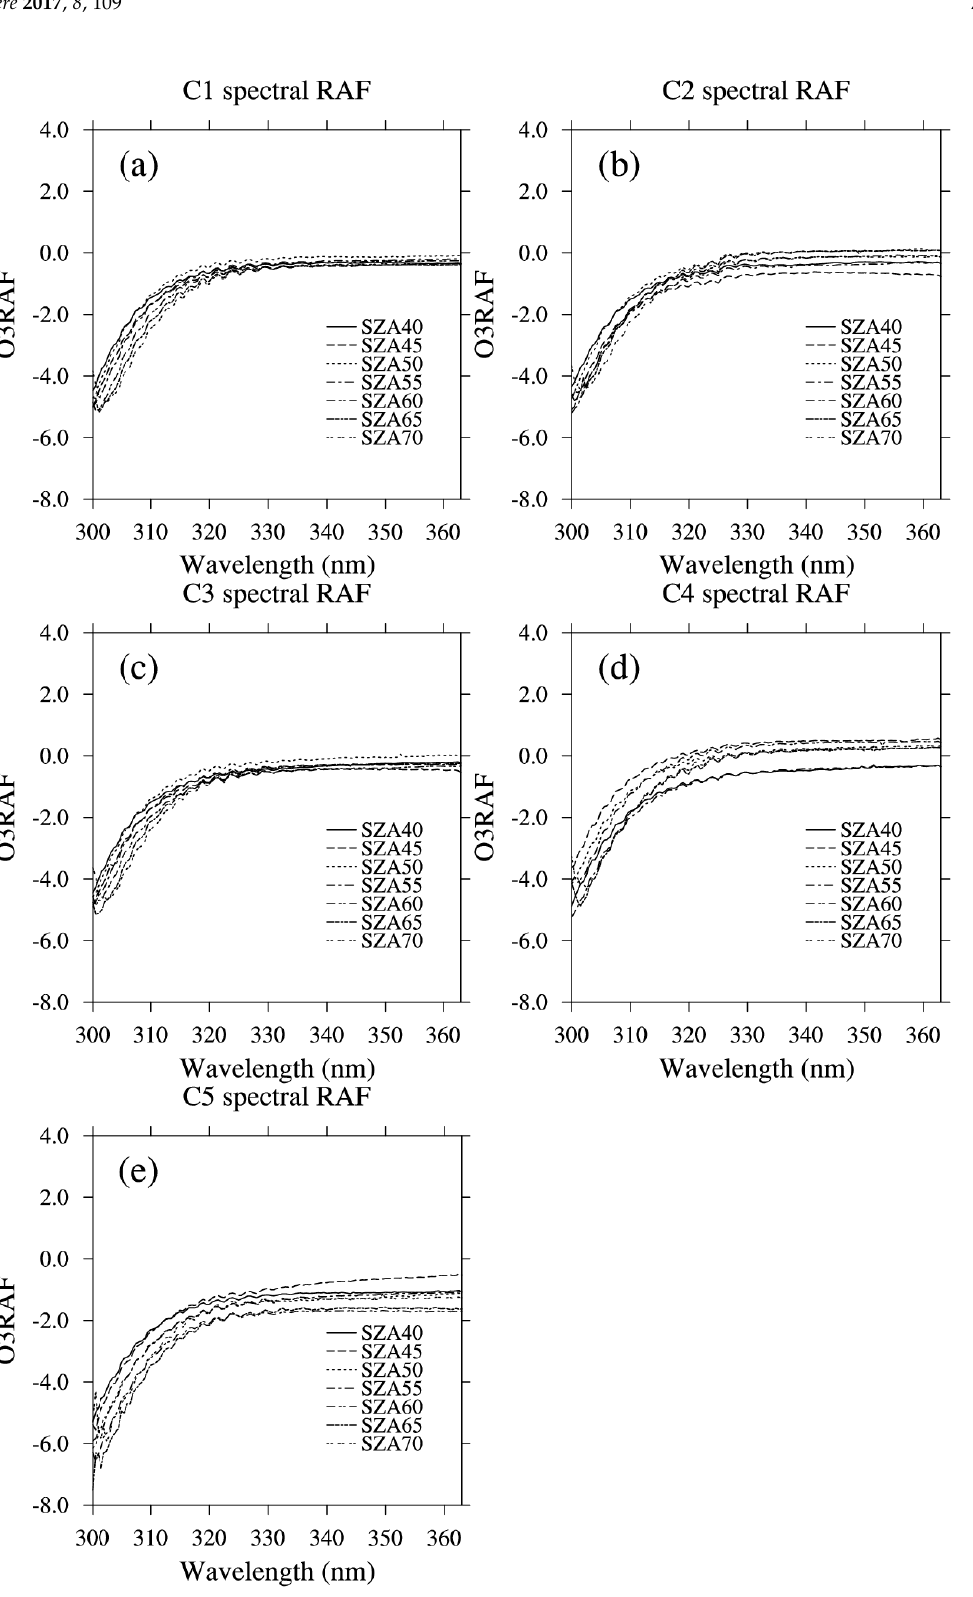
Figure 3. Spectral O3RAF from the observation for: ( a ) C1; ( b ) C2; ( c ) C3; ( d ) C4; and ( e ) C5 cases.